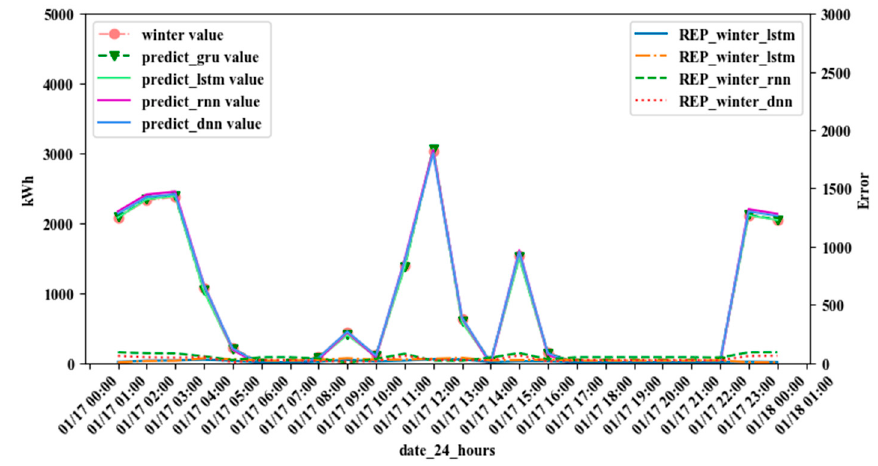
Figure 10. Predictions and REP of the winter scenario. Table 1. Performance comparison of deep learning based methods. NRMSE: normalized root mean